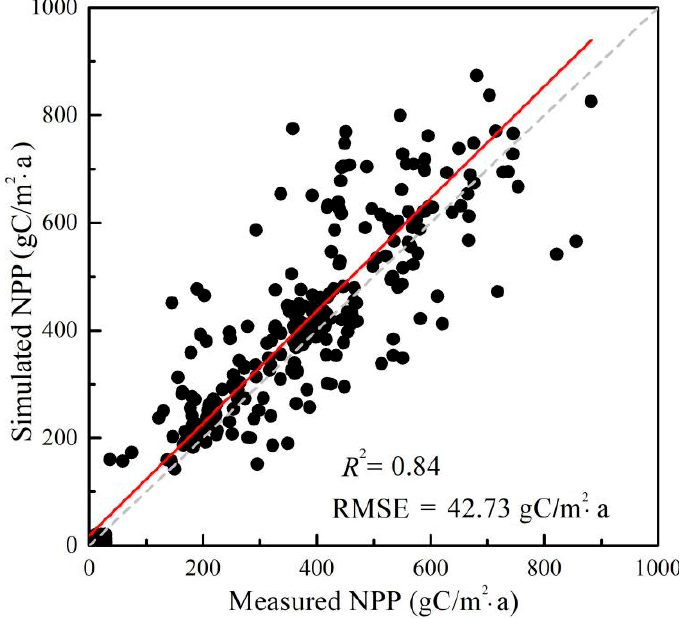
Figure 1. Validation of the simulated net primary productivity (NPP) from the boreal ecosystem productivity simulator (BEPS) model.